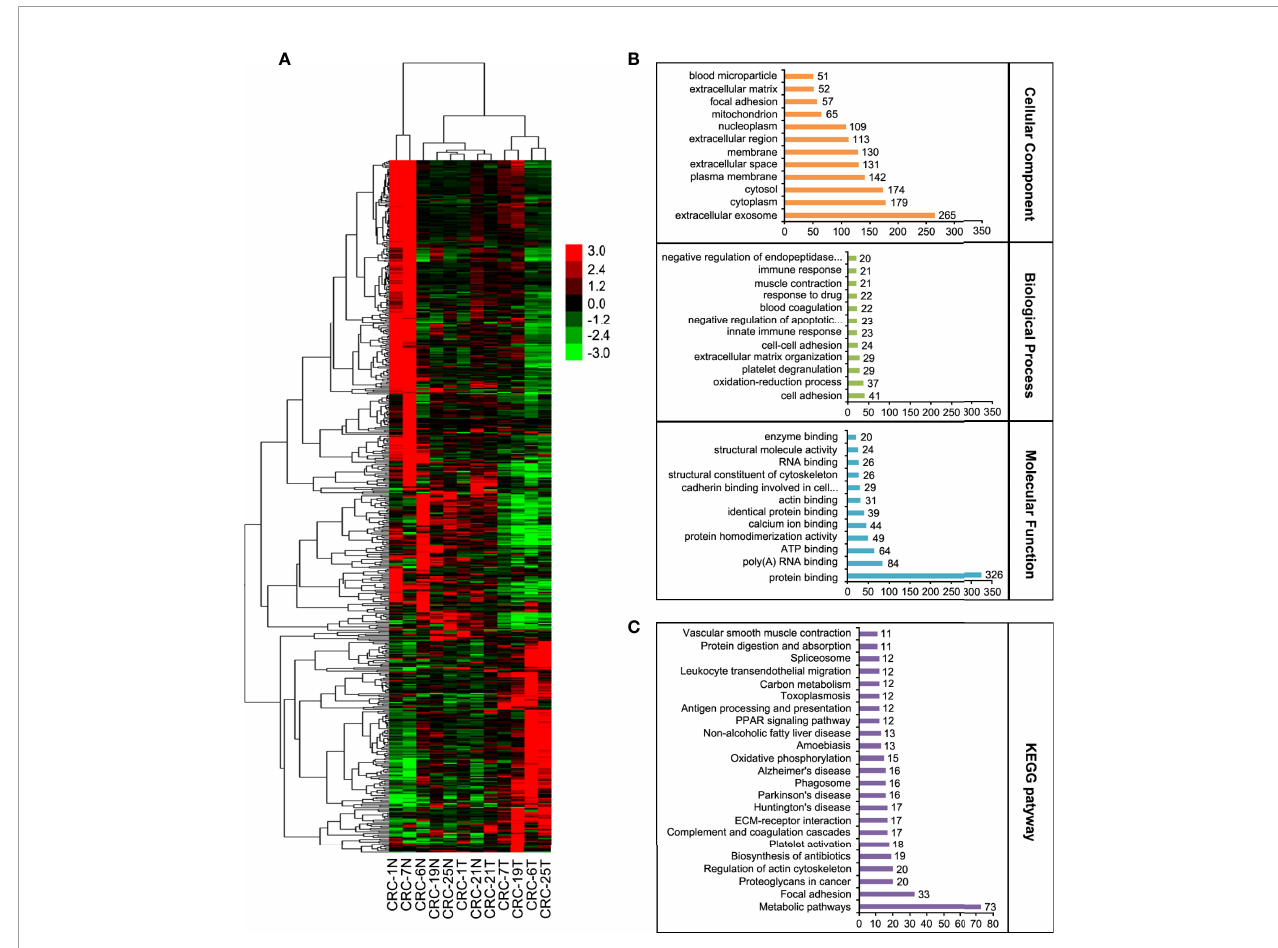
FIGURE 1 | Label-free quantitative proteomic analyses. (A) The heat map of LC-MS/MS data analysis from the six CRC tumor tissues and their adjacent normal tissues. (B) Classi fi cation of differential proteins according to the GO analyses. (C) Classi fi cation of differential proteins according to the KEGG